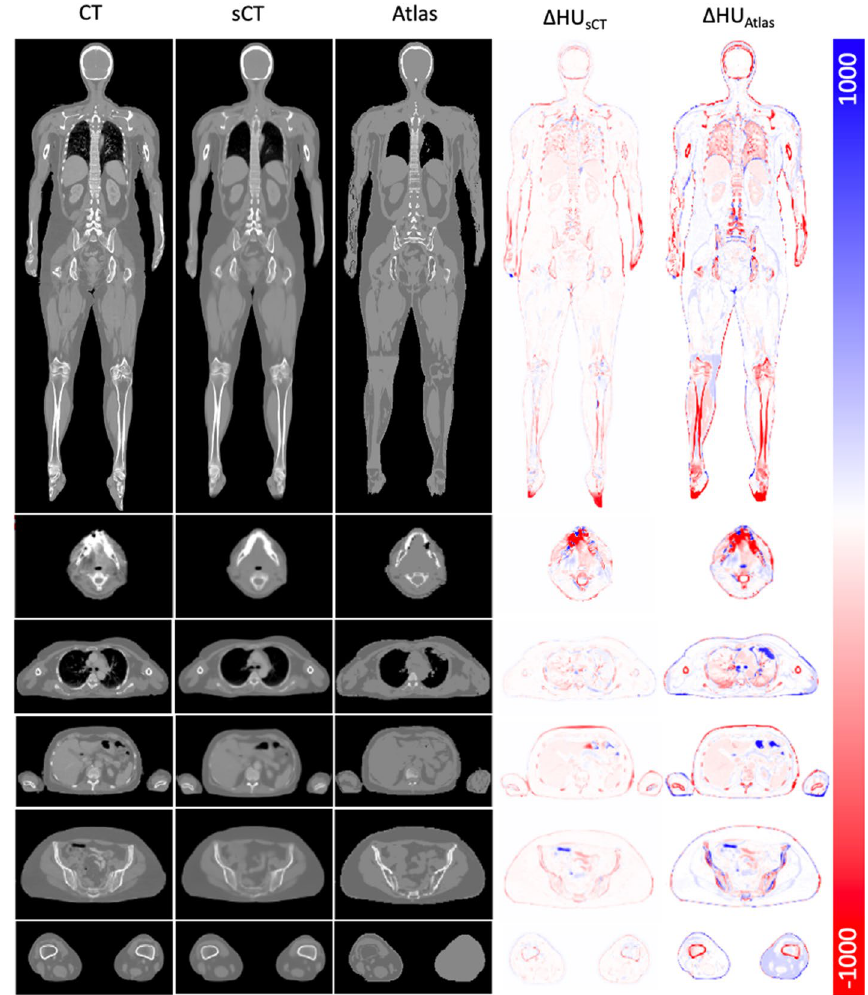
intersections. Presented from left to right: reference CT, deep learning-derived sCT, vendor-provided atlas-based map, the HU difference between CT and sCT, and the HU difference between CT and